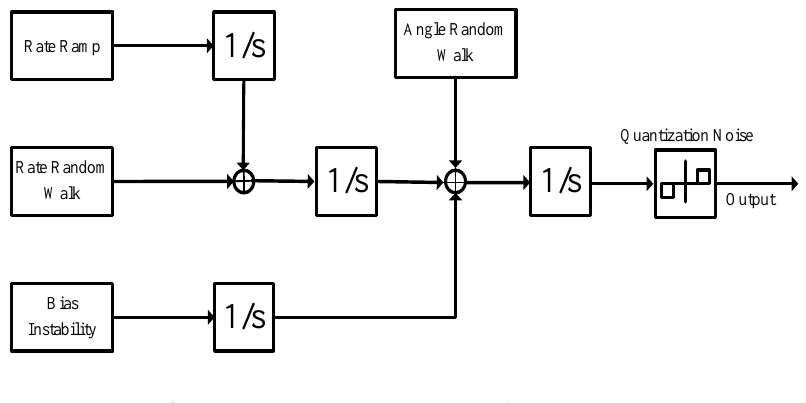
Figure 1. Stochastic model of inertial